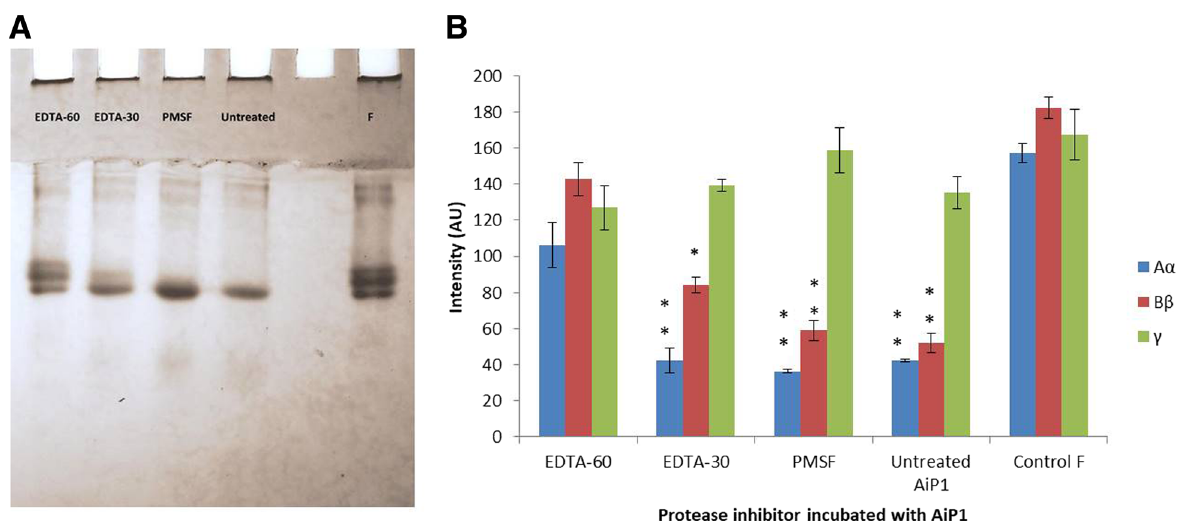
Fig. 5 Inhibition of fibrinogenolytic activity of AiP1 by EDTA: A Metalloproteinase nature of AiP1 was confirmed by estimating fibrinogenolytic activity of AiP1 post treatment with different inhibitors followed by incubating with fibrinogen to assess presence or loss of fibrinogenolytic activity post treatment. Lane 1: AiP1 treated with EDTA for 60 min; lane 2: AiP1 treated with EDTA for 30 min; lane 3: AiP1 treated with PMSF for 60 min; lane 4: untreated AiP1; lane 5: fibrinogen control. B Intensity of fibrinogen bands plotted against the AiP1 treated with various protease inhibitors. Digestion of A α band of fibrinogen was maximum in untreated AiP1, AiP1 treated with PMSF, and AiP1 treated with EDTA for 30